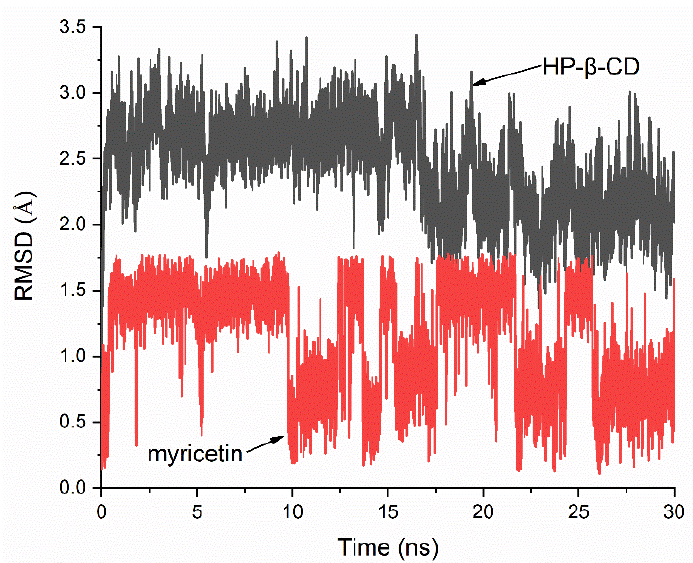
Figure 7. Root-mean-square deviation (RMSD) plots of all atoms for HP-β-CD: myricetin complex.